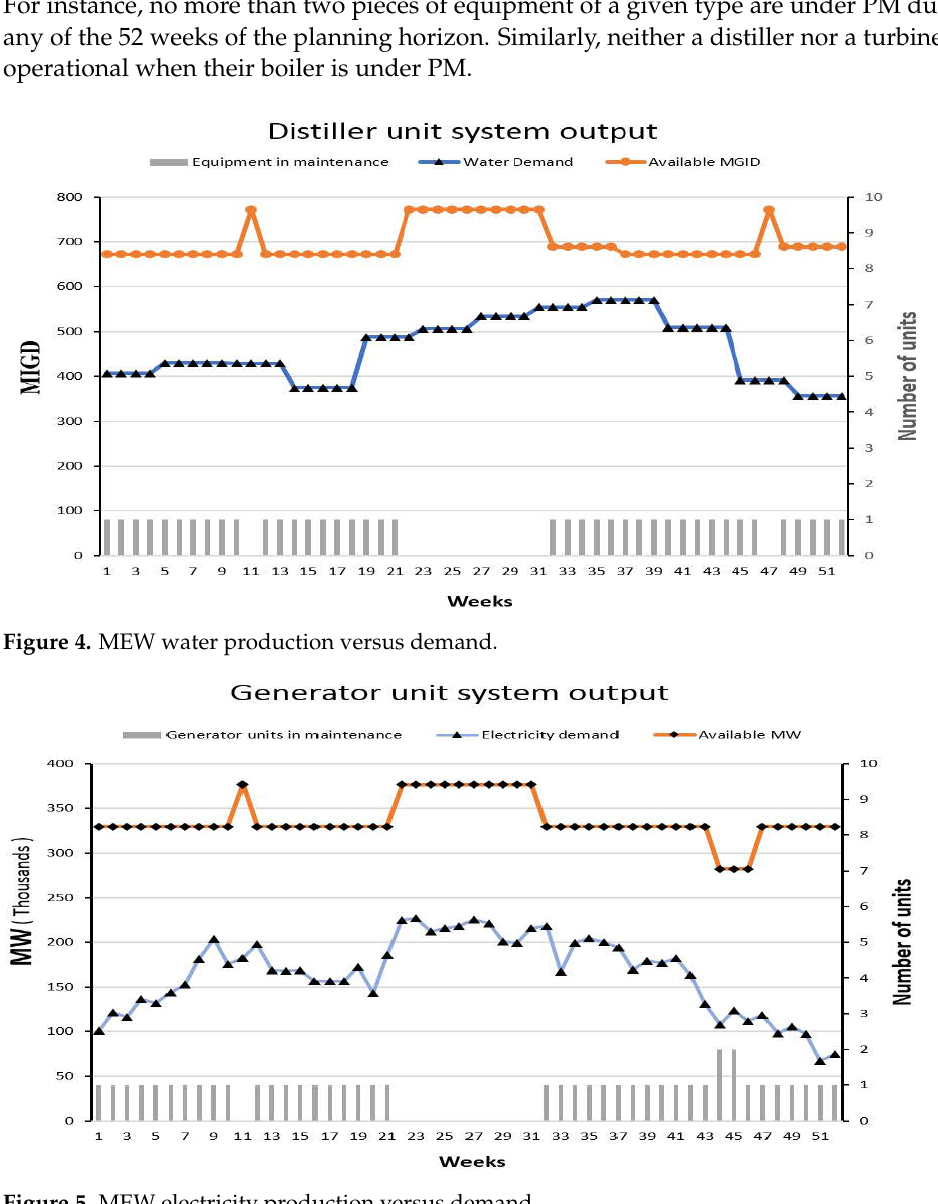
Figure 5. MEW electricity production versus